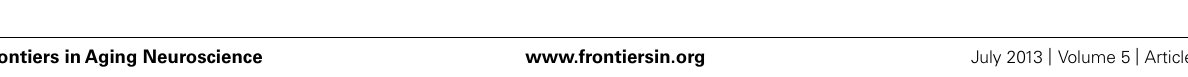
Frontiers inAging